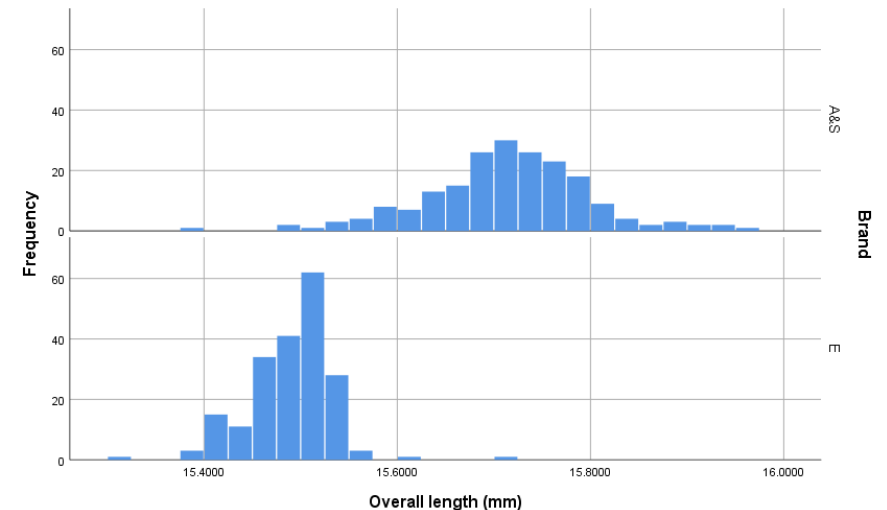
Figure 3. Neck diameter (mm) (OD Inner Figure 1) of cartridges within the sample groups. n = 200 per group demonstrating greater tolerance accuracy in the manufacturing process for Eley (E) cartridges and that Accles and Shelvoke (A&S) cartridges had a smaller diameter neck.